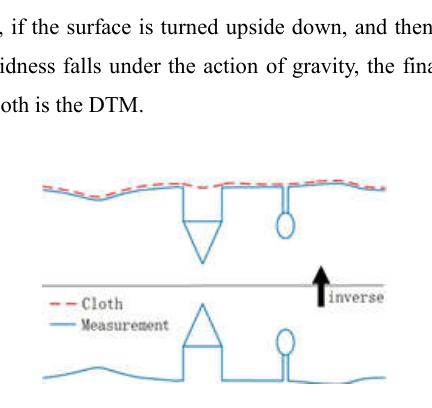
Figure 1.Overview of the CSF algorithm.